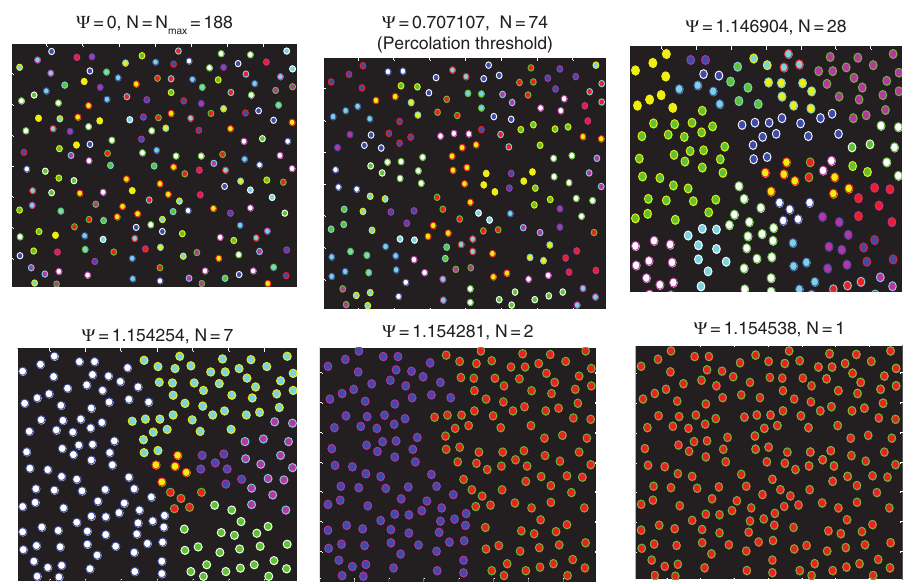
Figure 11: Progression of clustering with inconsistency coefficient for the range between highest and lowest values of inconsistency coefficient ( Ψ ) for a randomly seeded sample of vf =